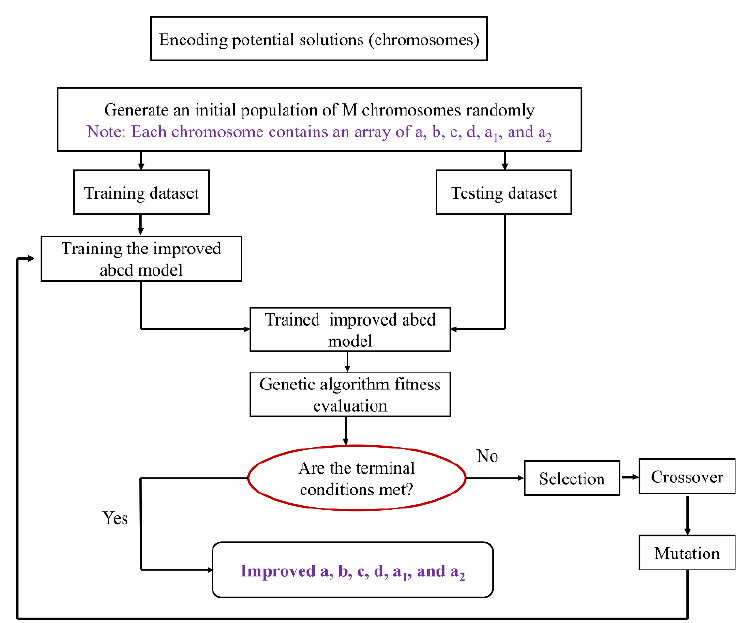
Figure A4. Flowchart of the parameter optimization base on genetic algorithm.